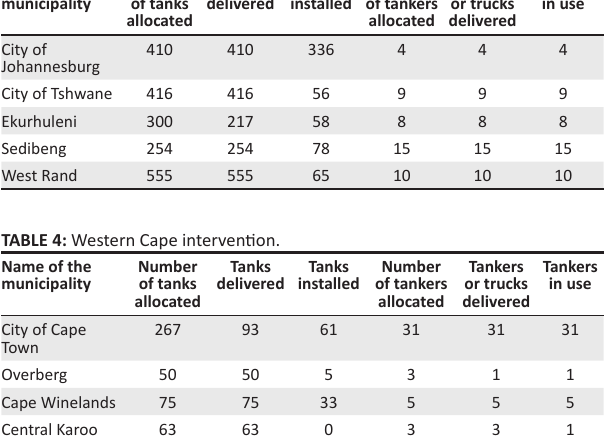
TABLE 3: Gauteng intervention as of 15 June 2020. Name of the Number municipality of tanks